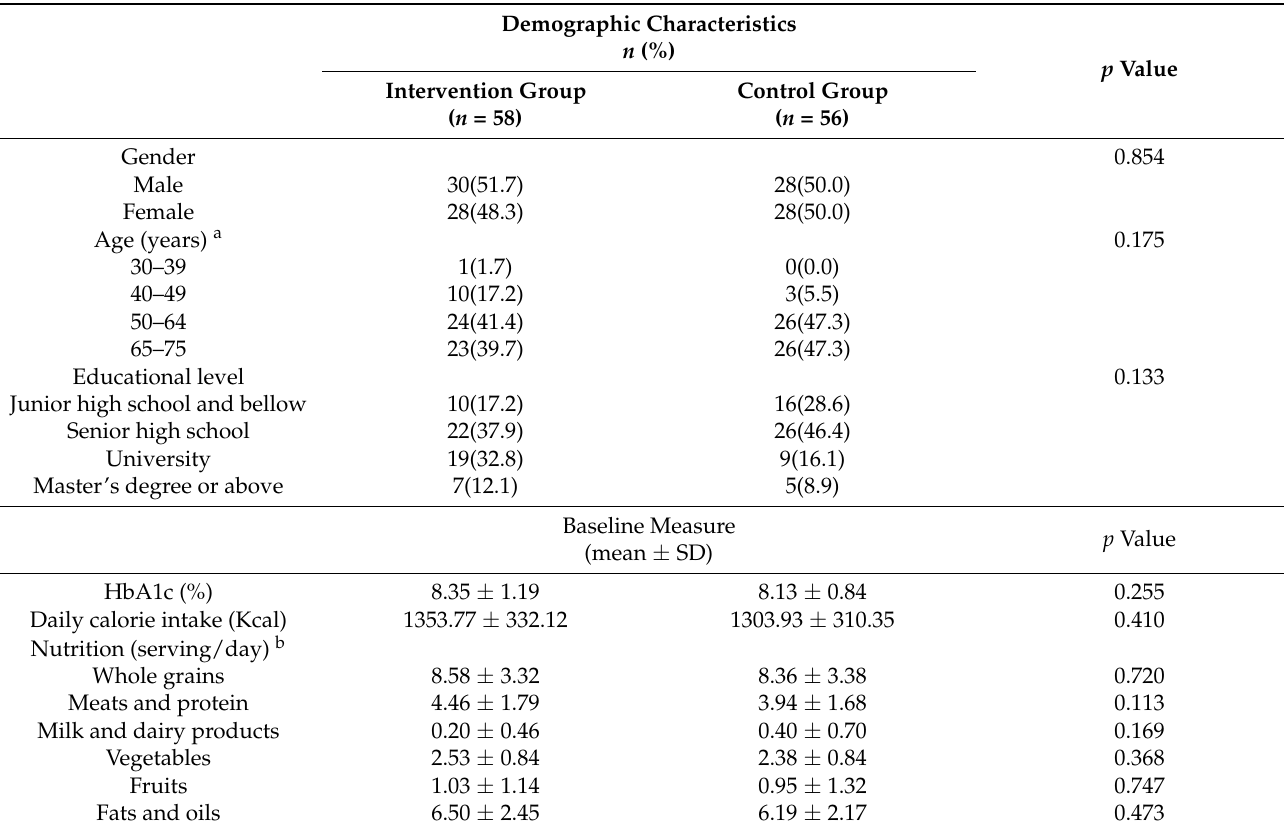
Table 1. Demographic characteristics and baseline value of study